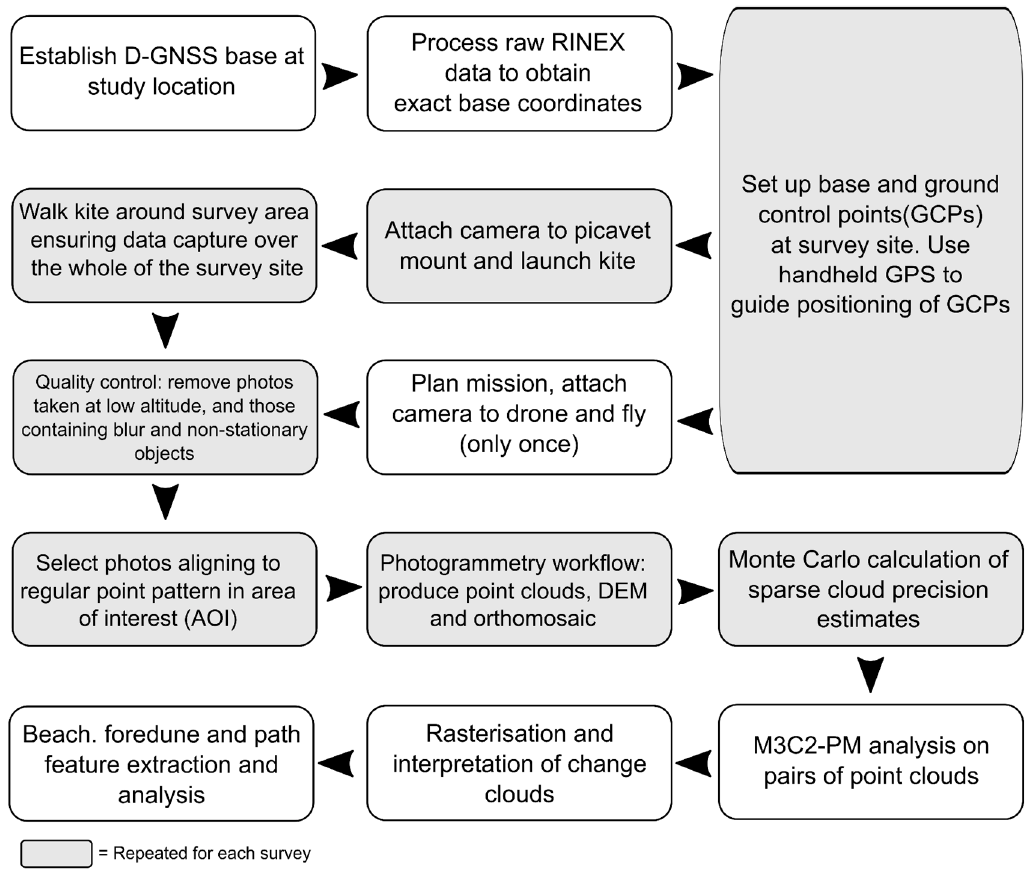
Figure 3. Data collection, processing and analysis workflow for KAP and drone